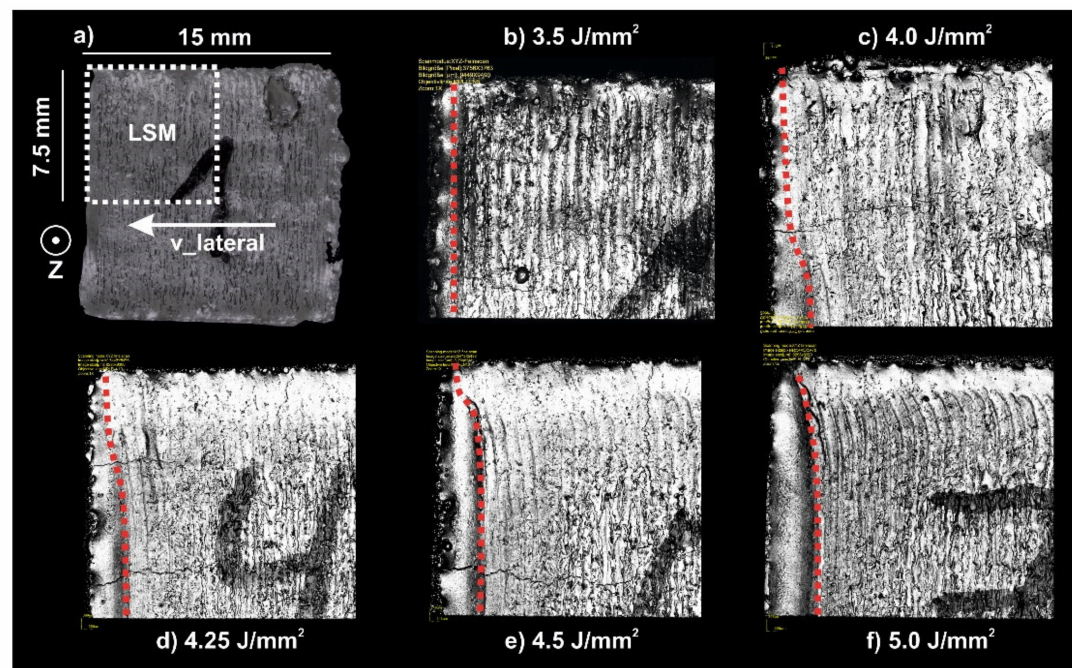
Figure 4. Influence of the energy input on the surface topography at a constant v_lateral. Lateral movement was from right to left. ( a ): schematic drawing of the LSM measurement position. ( b – f ): LSM images of the development of residual melt pool shape with increasing energy input. (v_Beam: 400 mm/s, hatch distance: 200 µ m, v_lateral: 5.33 mm/s).